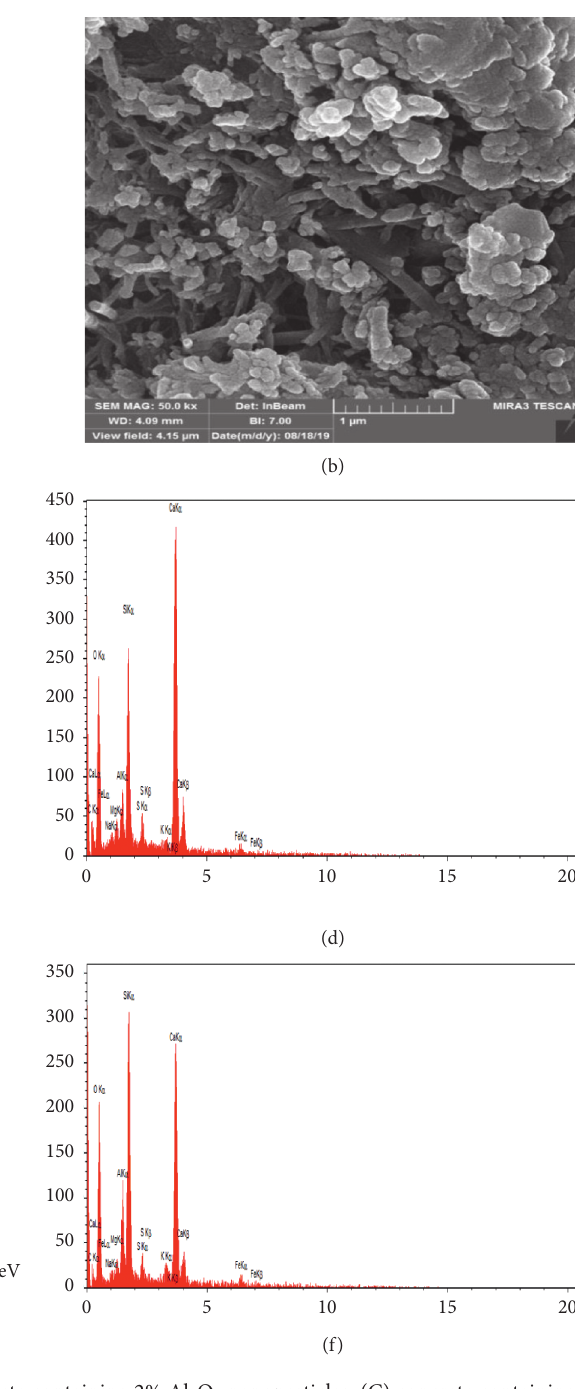
2 O 3 nanoparticles, (C) concrete containing 2% GO/